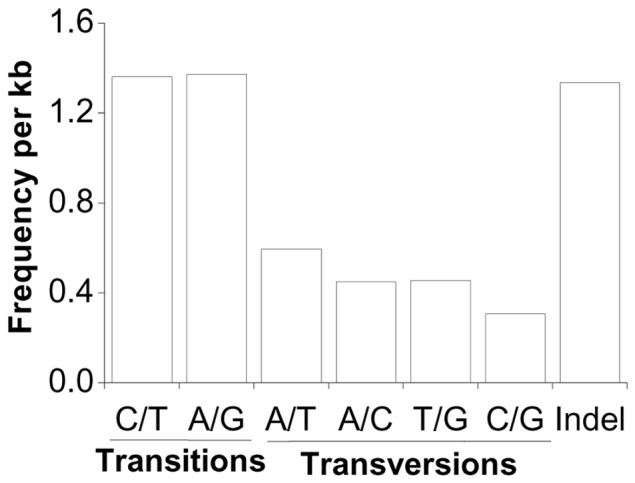
Classification of single nucleotide polymorphisms (SNPs) indentified in the C.
sinicus transcriptome.The overall frequency of these SNPs is one per 179 bp.